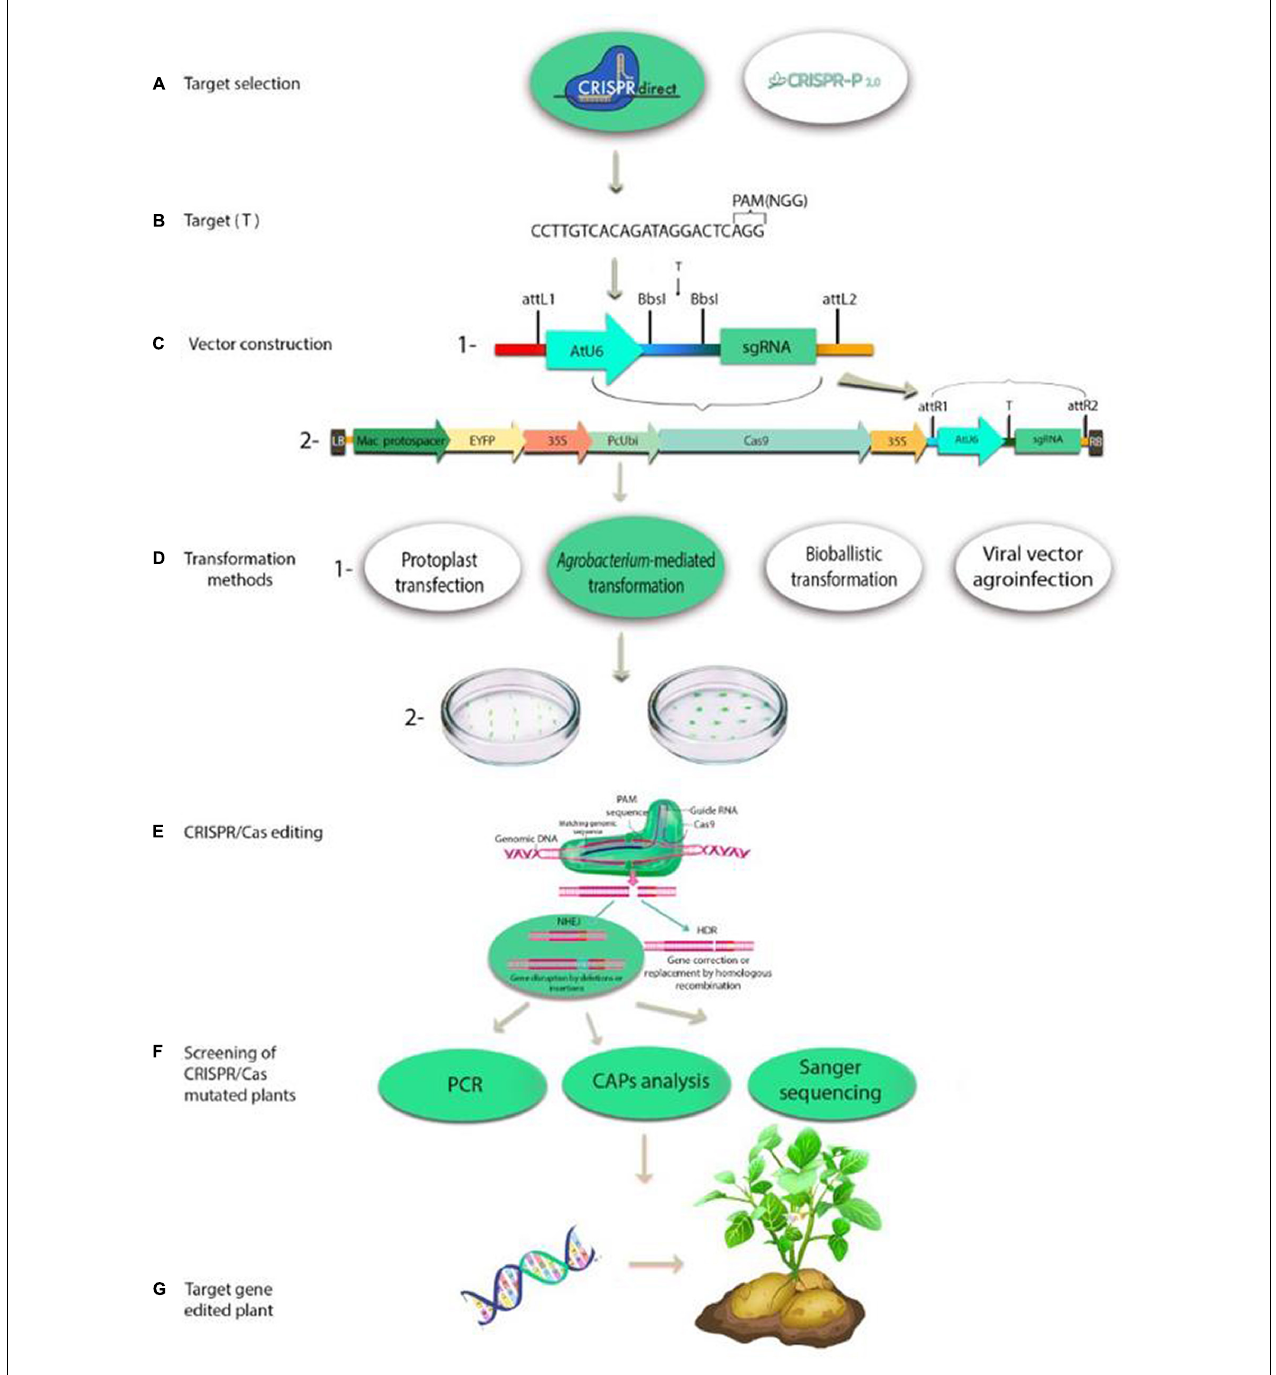
FIGURE 1 | Schematic representation of plant genome editing with CRISPR/Cas: (A) Examples of software tools available for CRISPR sgRNA design; (B) The 20-bp target sequence with protospacer adjacent motif (PAM); (C) (1) Representation of cloning the 20-bp target sequence into the pair of BbsI sites in gRNA cloning vector; (2) Representation of cloning the gRNA expression construct into all-in-one binary vector by the recombination of attL and attR sites; (D) (1) Plant transformation methods are used for delivery of CRISPR/Cas9 system: protoplast transfection with polyethylene glycol (PEG) or via electroporation; Agrobacterium -mediated transformation; bioballistic transformation and viral vector agroinfection. (2) Examples of plant tissues used as the explants for transformation; (E) Diagrammatic representation of the CRISPR/Cas editing system: CRISPR/Cas induces double-stranded breaks in genomic DNA strands. The PAM sequence is primarily required for the Cas9 to cleave DNA. A stretch of 20 bases of sgRNA defines the binding specificity. Two methods repair the DSBs in DNA: non-homologous end-joining (NHEJ), which is not precise and permanently results in a gene knockout and homology-directed repair (HDR), which is activated in the presence of a template and results in knockin or gene replacement; (F) Screening of CRISPR/Cas mutated plants by polymerase chain reaction (PCR) analysis, cleaved amplified polymorphic sequences (CAPs) analysis and Sanger sequencing; (G) Target gene-edited plant in a potato example.